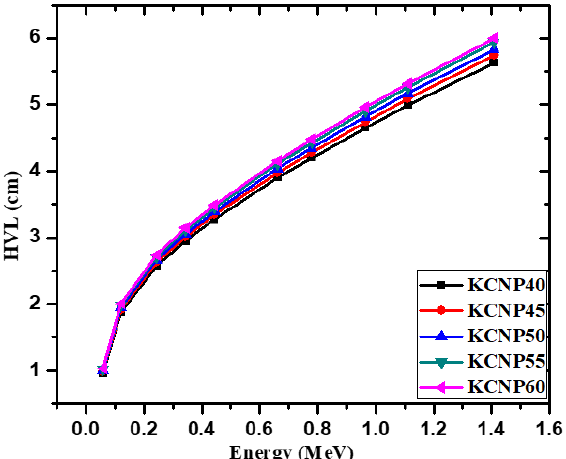
Figure 6. Half value layer for the fabricated glasses.